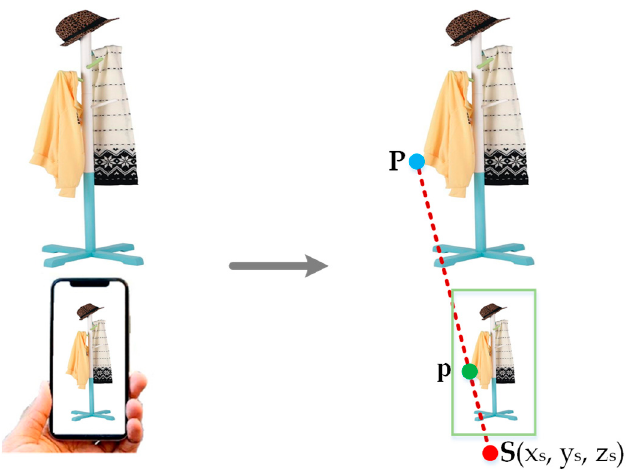
Figure 6. The schematic diagram of three-point collinearity in smartphone photography.